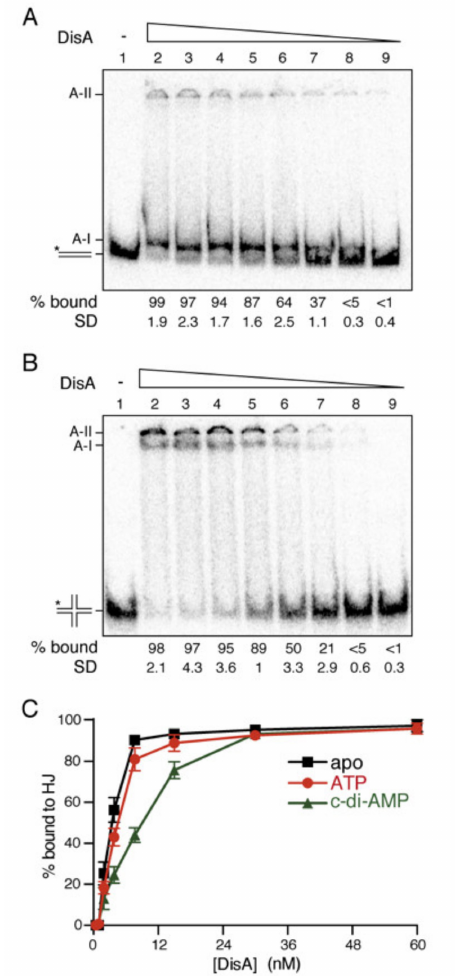
Figure 1. DisA binding to DNA. [ γ - 32 P] dsDNA ( A ) or [ γ - 32 P] HJ DNA ( B ) was incubated with increasing DisA concentrations (doubling from 0.45 to 60 nM) in buffer C containing 10 mM MgCl 2 , and after fixation, complexes were detected by EMSA. Experiments were repeated at least 3 times. A representative gel and below the mean % of DNA bound and its SD are shown. A-I denotes complexes entering the gel and A-II denotes complexes retained in the well. ( C ) ATP or c-di-AMP barely affects DisA binding to HJ DNA. [ γ - 32 P] HJ DNA was incubated with increasing DisA concentrations (15 min at 37 ◦ C) in buffer C containing 10 mM MgCl 2 or 10 mM MgCl 2 and 500 µ M ATP or c-di-AMP (15 min at 37 ◦ C). The complexes, detected by EMSA, were quantified. Results are shown as the mean ± SEM of >3 independent